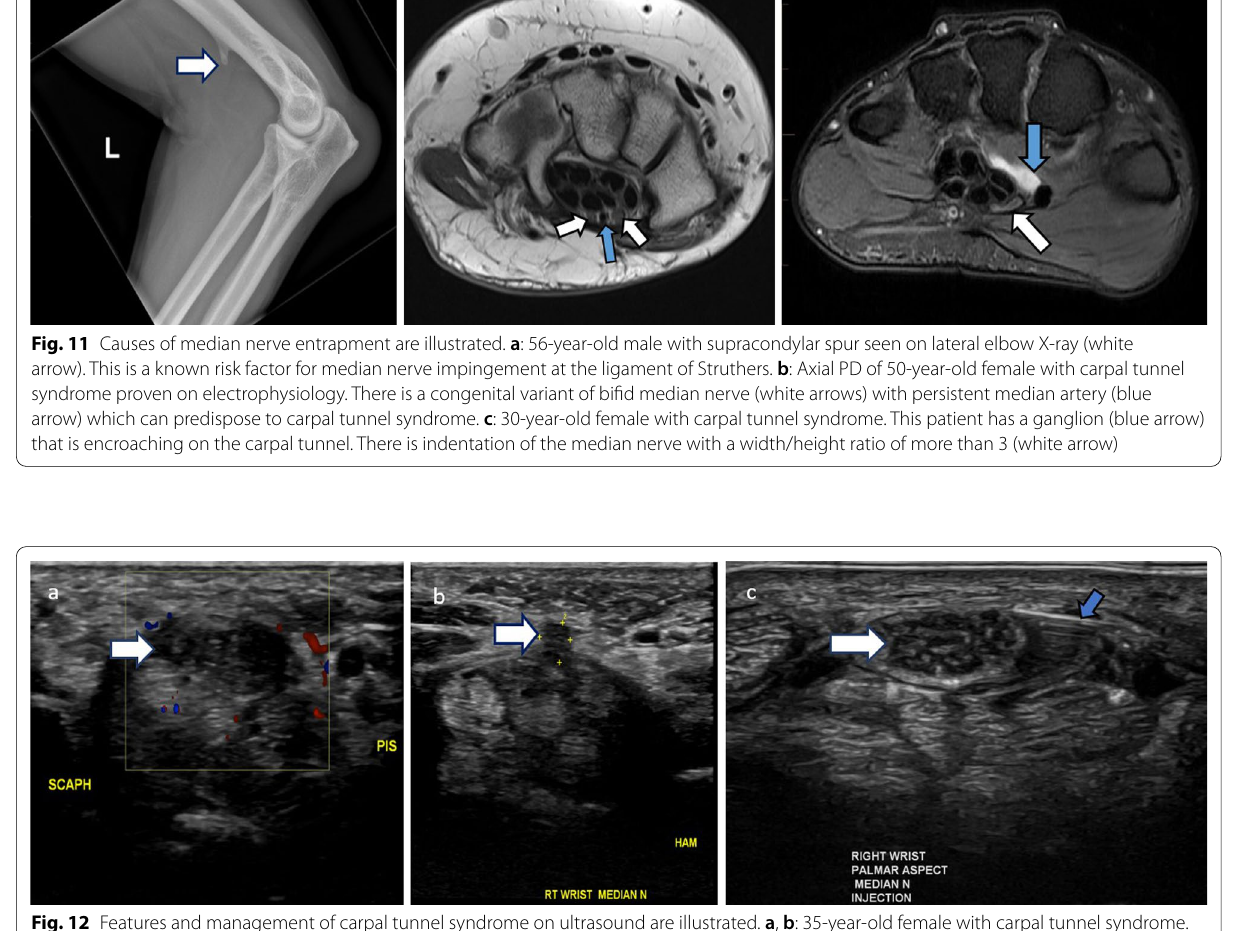
tunnel and at the ulnar canal [17]. The cubital tunnel syndrome is the most common ulnar neuropathy. It is associated with the presence of the anconeus epitroch- learis, an accessory muscle present in up to 34% of the population. This muscle may compress the nerve against the medial epicondyle or olecranon of the humerus. This condition has also been linked with prolonged elbow flexion, for example in truck drivers. The ulnar canal is a less common site of entrapment, and this mainly occurs in the context of mass lesions in the canal or extrinsic compression, for example “cyclist’s palsy” which is caused